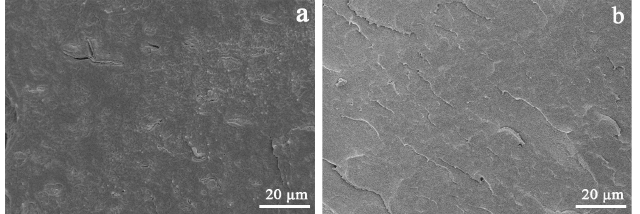
Figure 11. The SEM micrographs of the iPP/NA-21 composite ( a ) and iPP-3 composite ( b ).